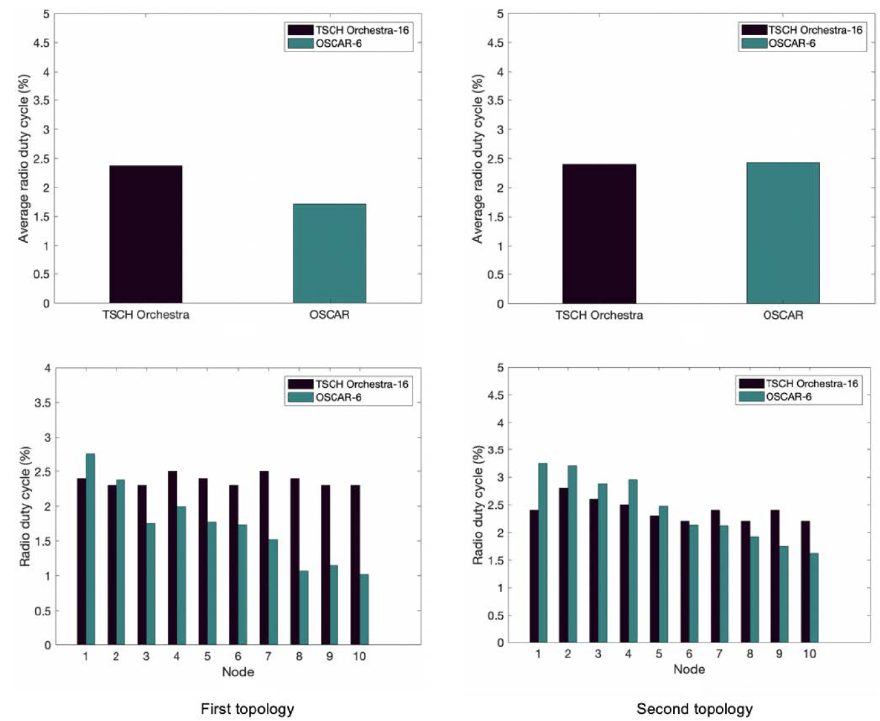
Figure 5. Average duty cycle of OSCAR and Orchestra for the first and second topology.